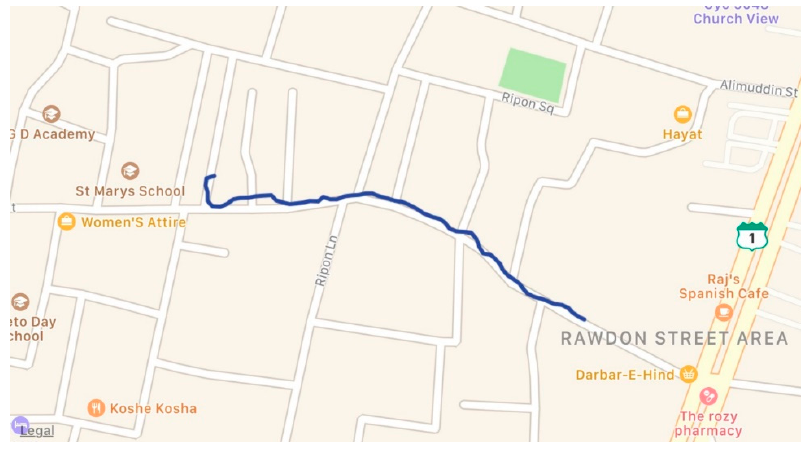
Figure 4. Journey in Rawdon Street.